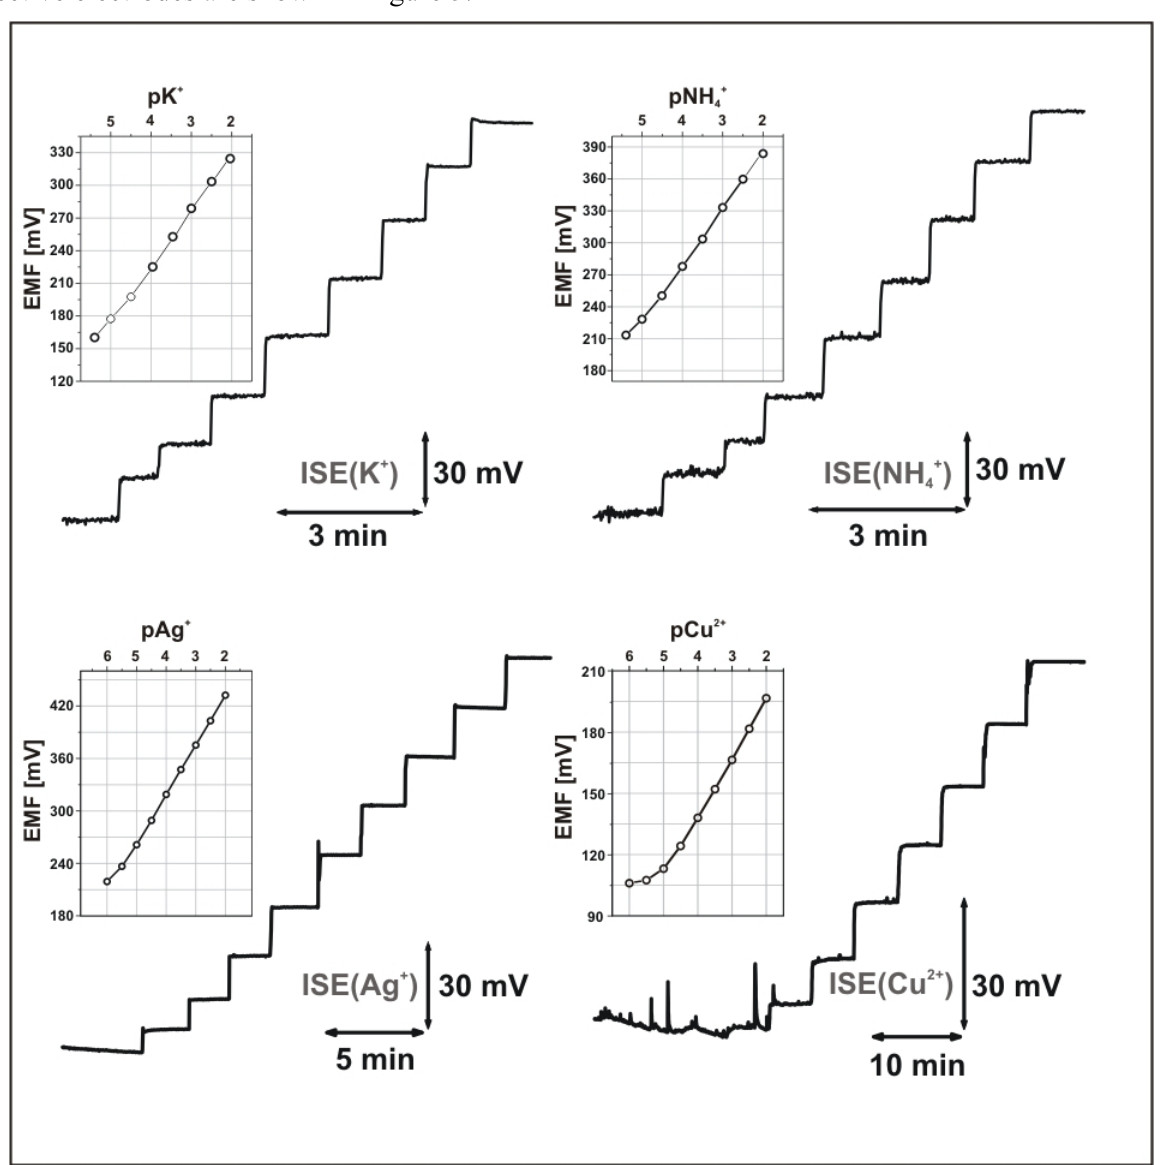
Figure 5. Typical responses and corresponding calibration graphs of the developed thick-film ion-selective